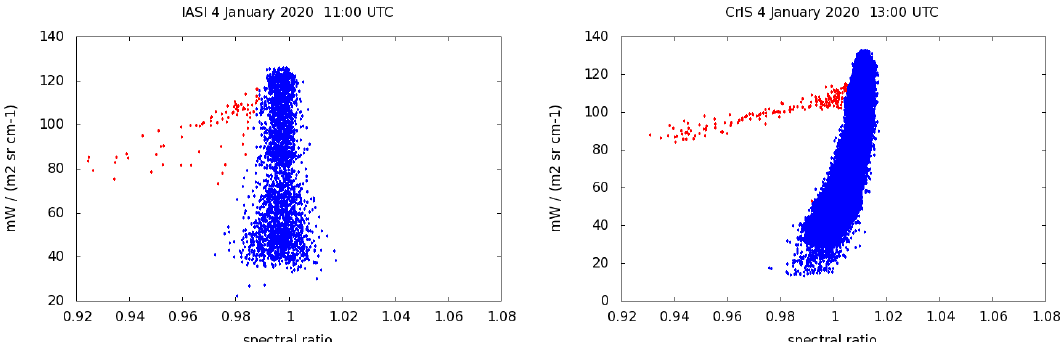
Figure 2. Examples of spectral ratio distribution for IASI ( left ) and CrIS ( right ). The pixels outside the main distribution (red) correspond to the pixels detected within the plume with the method described in the text. The blue points correspond to the pixels outside the plume.